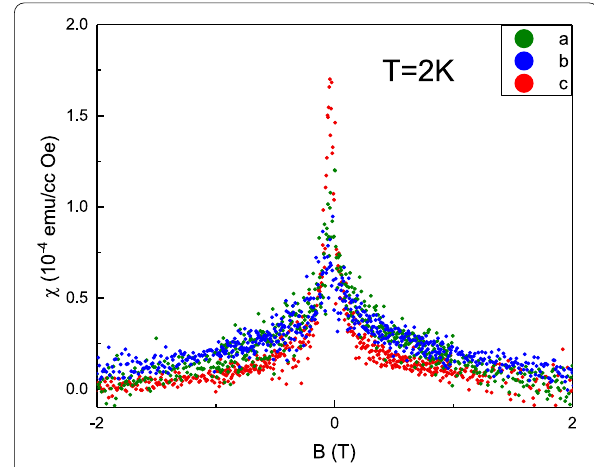
Fig. 7 The measured magnetic field‑dependent susceptibility in three orthogonal directions at 2 K. It exhibits different peak maxima at zero magnetic fields which implies that observed paramagnetic peaks should not originate from a system with randomly and uniformly distributed ferromagnetic